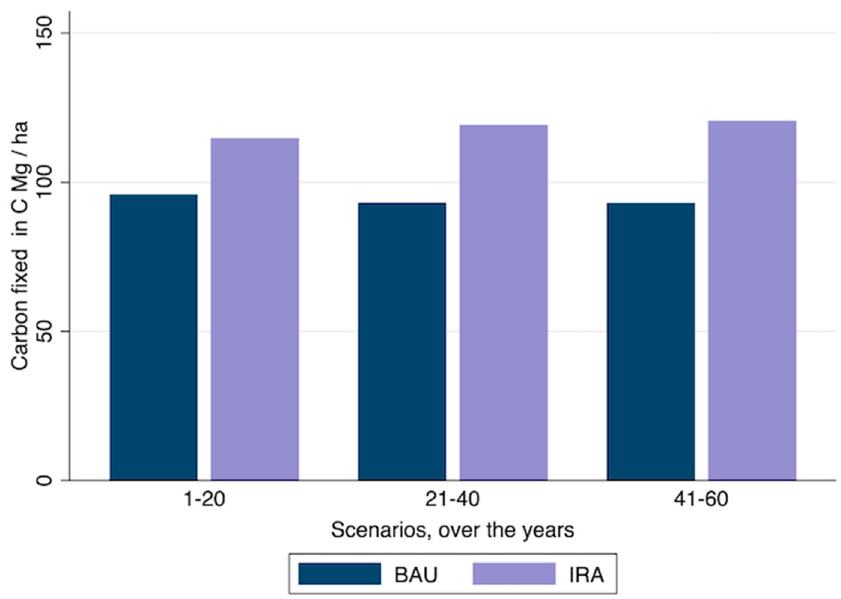
Figure 11. Simulation results: carbon sequestration in the landscape over time.